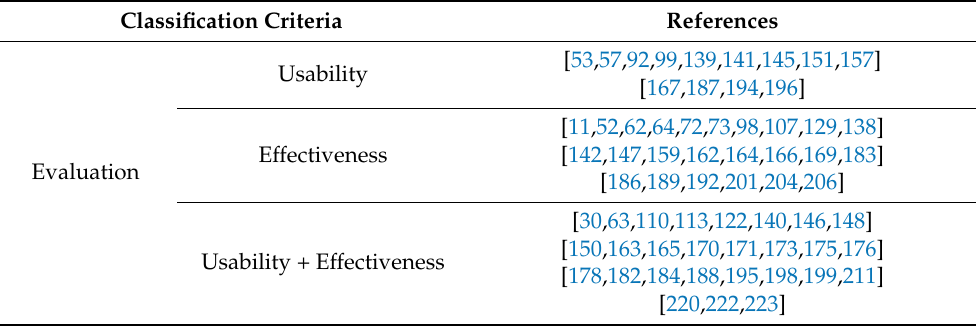
Table 17. Articles contributing for Layer 3 Evaluation from 2010–2021. Classification